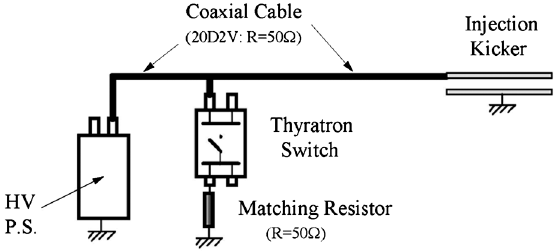
FIG. 17. Pulse forming network for the injection kicker.